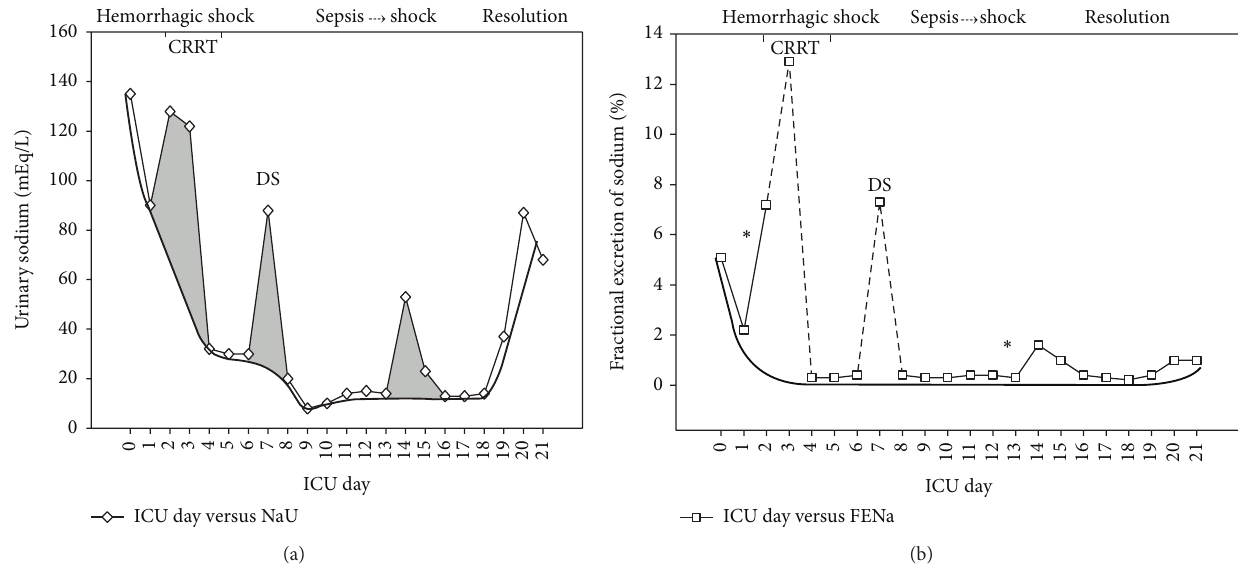
Figure 3: Urinary sodium (NaU) (a) and fractional excretion of sodium (FENa) (b) in the course of hemorrhagic shock and subsequent septic shock. Grey areas represent increases in NaU attributable to furosemide administration. The bold lines represent the hypothetical course of NaU and FENa in the absence of diuretic and CRRT interference. The dashed lines represent the period in which FENa is unreliable due to CRRT. ∗ indicates furosemide administration and its influence in FENa. CRRT: continuous renal replacement therapy DS: conventional dialysis. ICU: intensive care